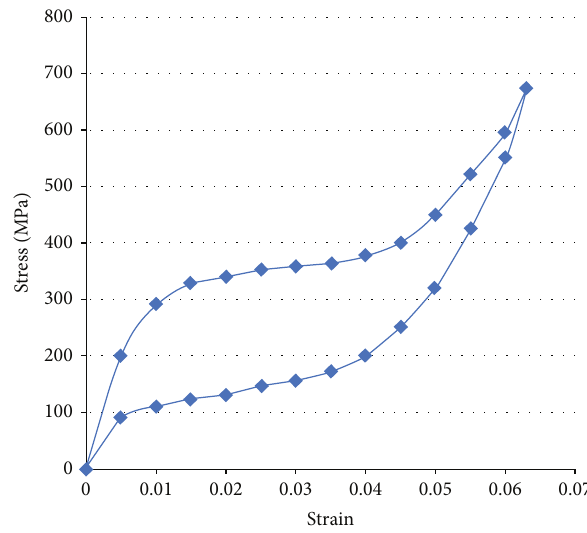
Figure 1: Strain-stress curves of Ti-Ni